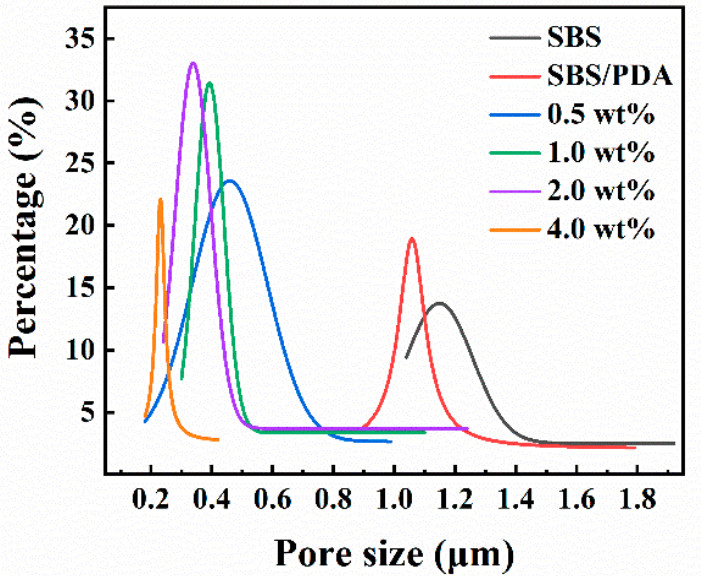
Figure 2. SEM images of ( a ) the SBS fibrous membrane, ( b ) the SBS/PDA fibrous membrane and ( c )– ( f ) the SBS/PDA/SiO 2 fibrous membrane with SiO 2 NPs concentrations of ( c ) 0.5 wt%, ( d ) 1.0 wt%, ( e ) 2.0 wt% and ( f ) 4.0 wt%, respectively.